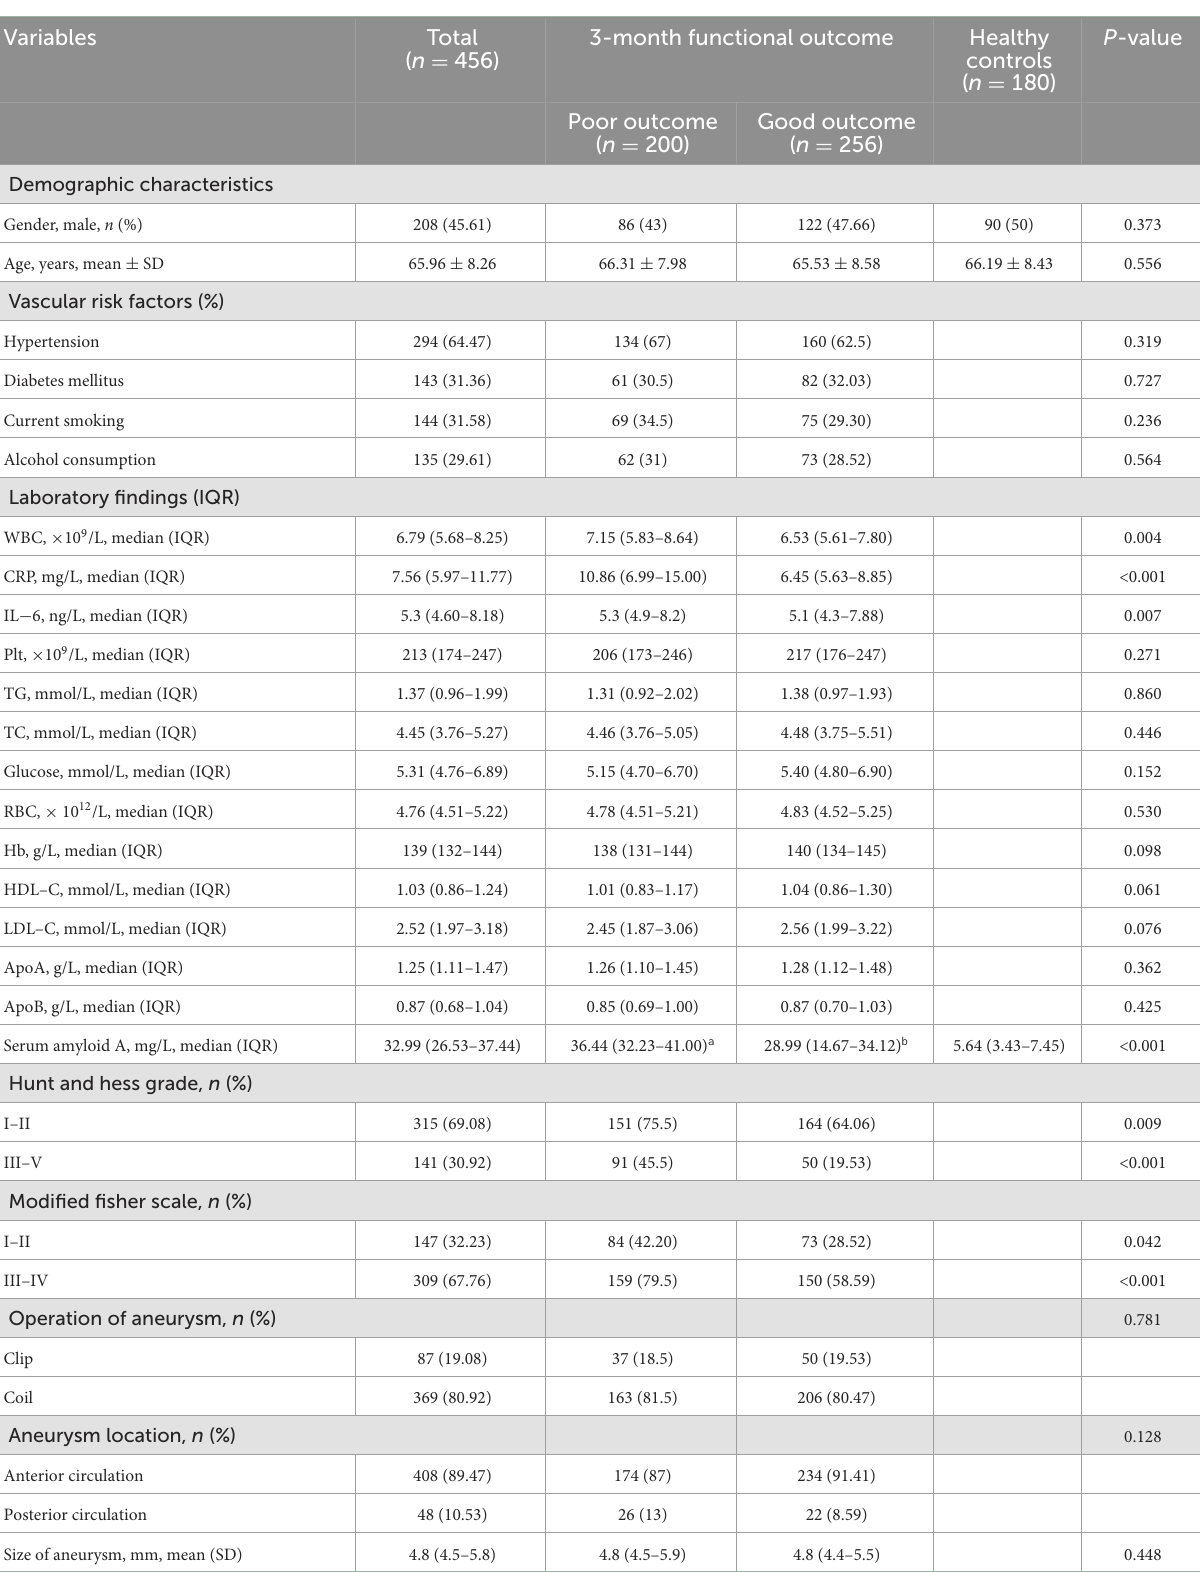
TABLE 1 Clinical and demographic characteristics of the samples under study.